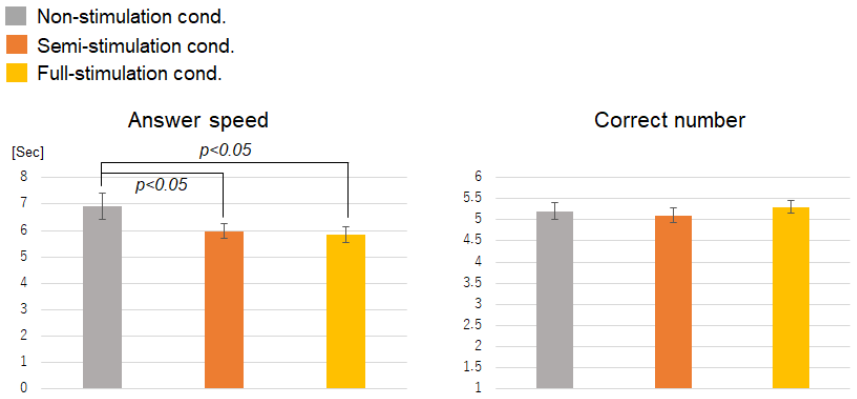
Figure 6. The average score of answer speed and correct number for each